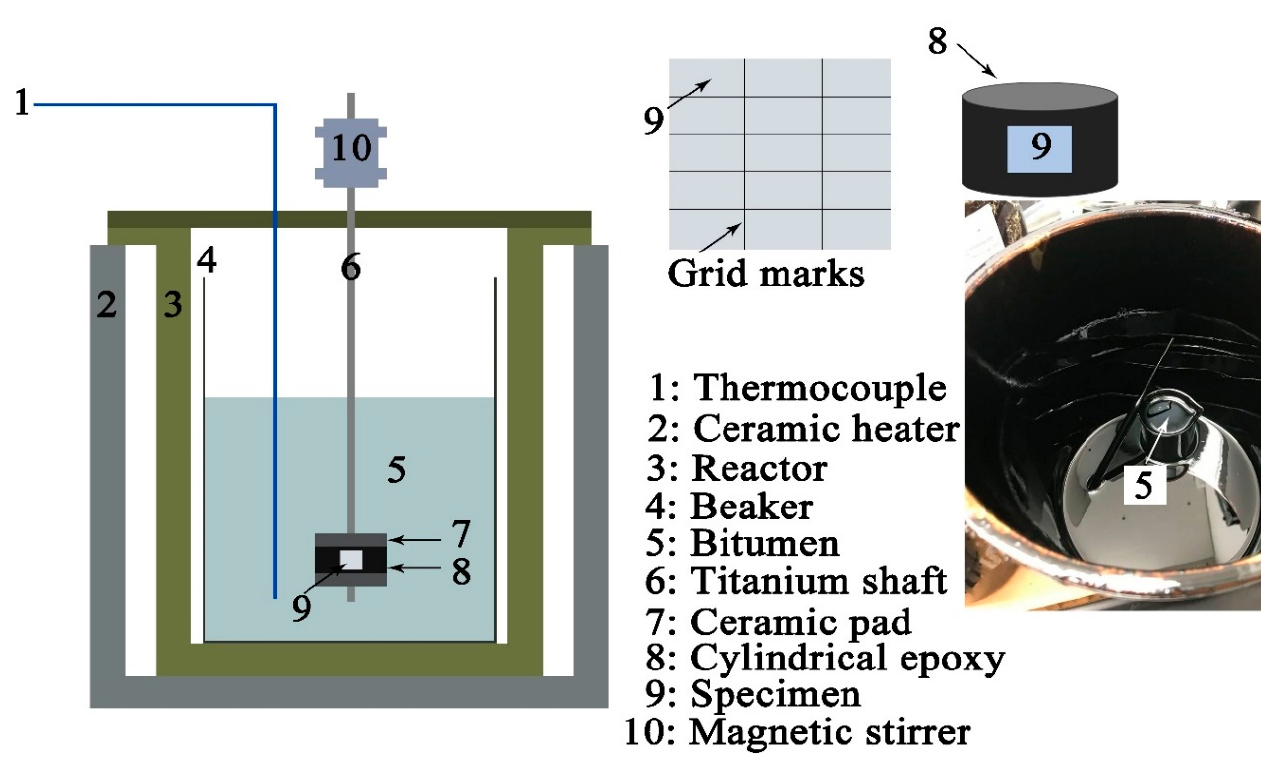
Figure 1. Schematic of the autoclave setup used to examine the corrosion of API-X100 pipeline steel in bitumen at 60 and 120 °C. Bitumen is shown at right in an unrelated separate bucket.